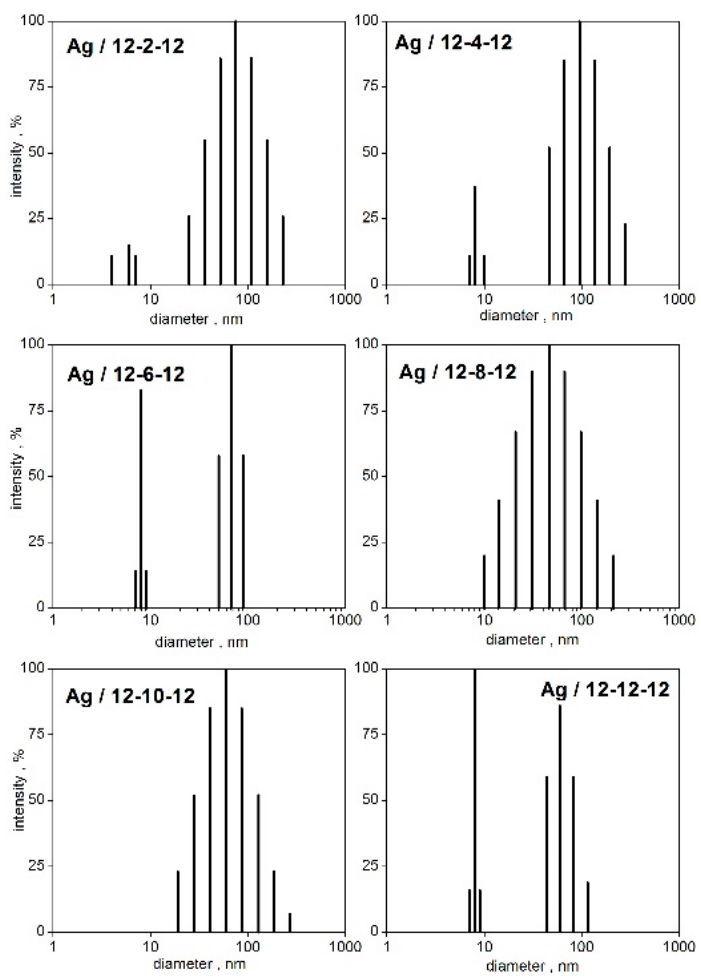
Figure 7. CONTIN particle size distributions of silver nanoparticles stabilized with gemini surfactants 12- s -12 at the molar ratio n Ag /n 12- s -12 = 3.3.